Question: What visual encoding does this figure use to show its data?
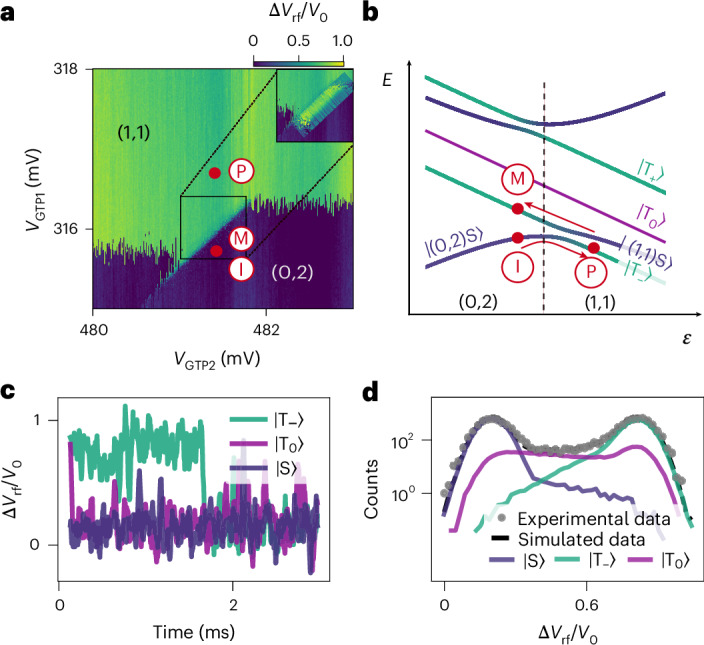
Answer: scatter